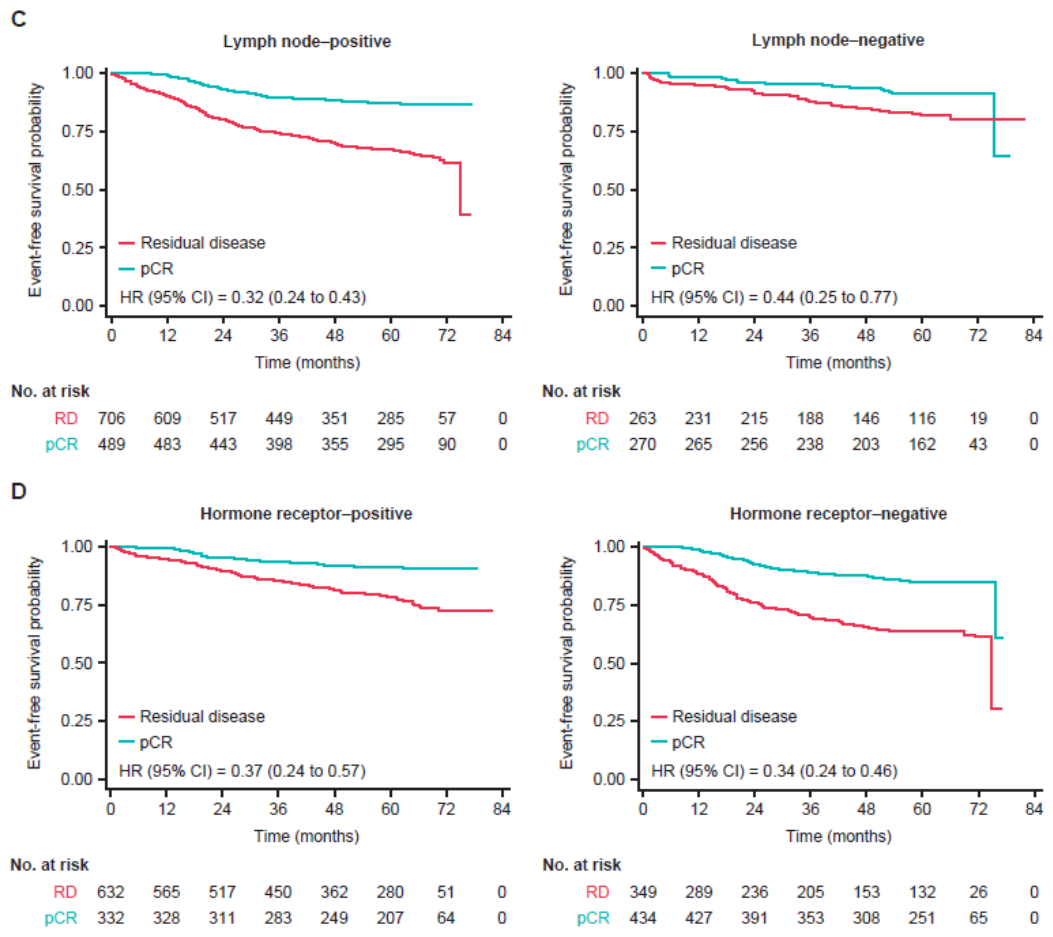
Figure 1. Event-free survival in patients with pCR after neoadjuvant systemic therapy ( A ) and by ( B ) clinical stage, ( C ) nodal status, and ( D ) hormone receptor status. The inverse probability of treatment weighting method was used to account for imbalances in the baseline factors of hormone receptor status, clinical stage, and age group. Abbreviations: CI, confidence interval; HR, hazard ratio; RD, residual disease.